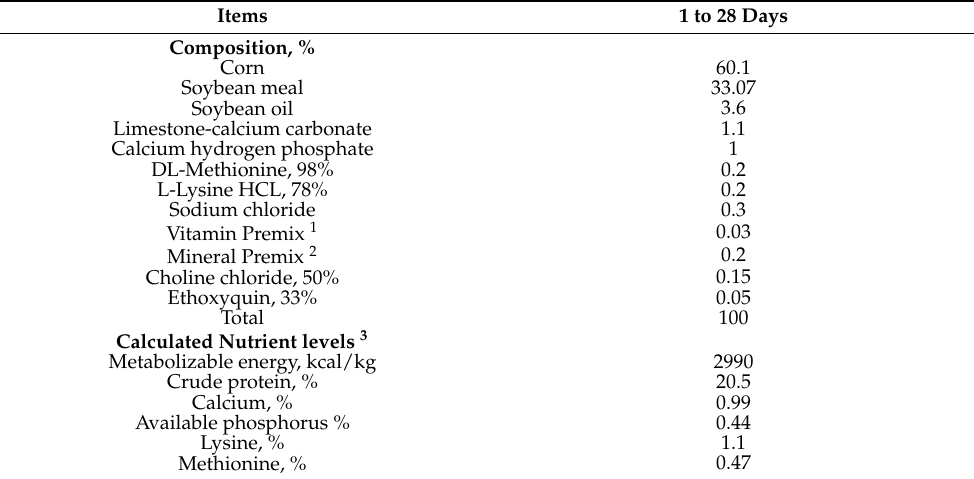
Table 1. Composition and nutrient levels of the experimental basal diet, on an as-fed basis unless stated otherwise,